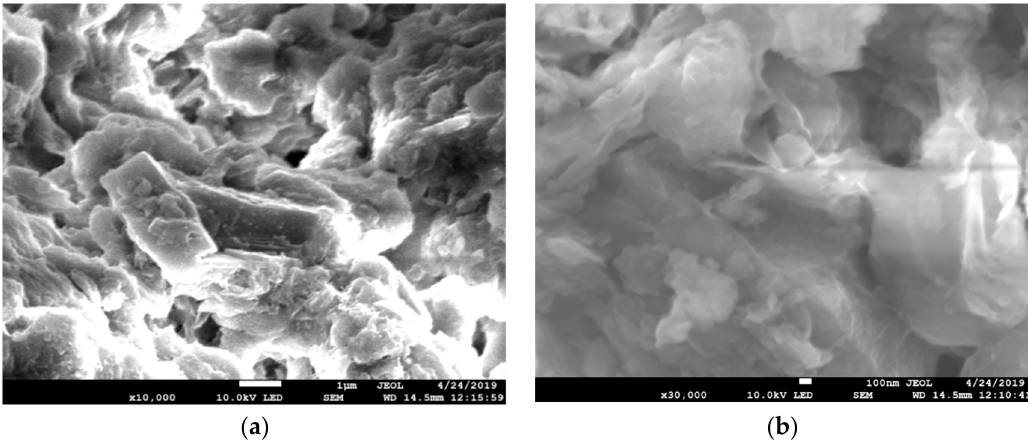
Figure 2. SEM images of( a )Na-bentonite, and ( b ) 1.4% CuO/bentonite(400°C) composite.